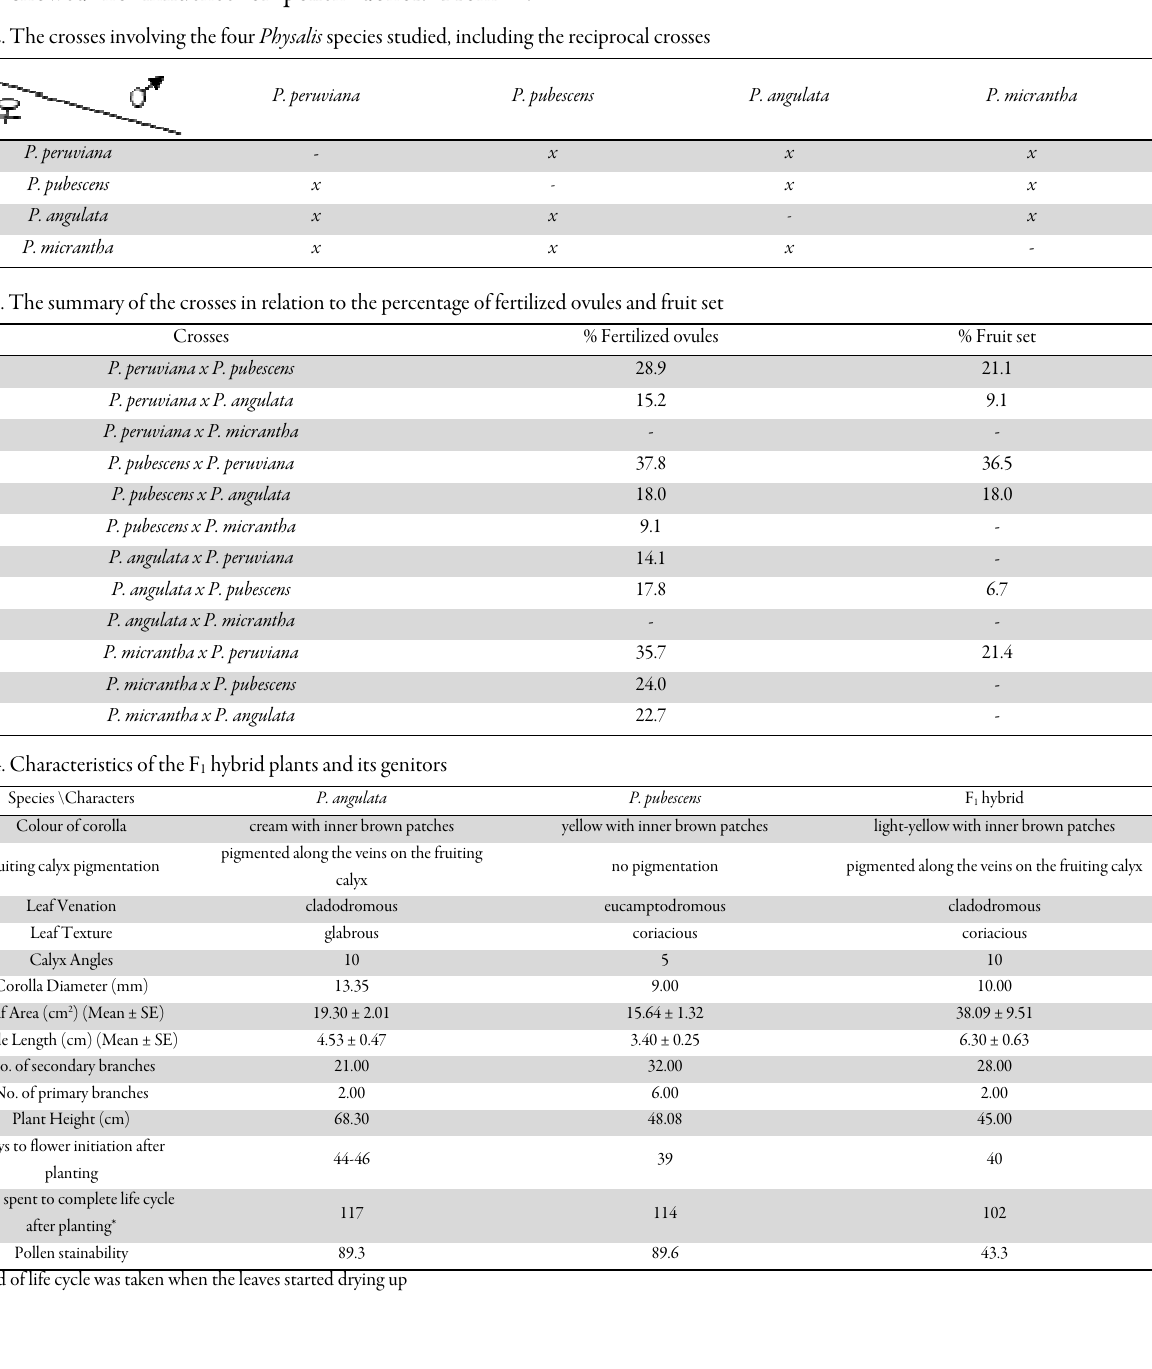
Table 2. The crosses involving the four Physalis species studied, including the reciprocal crosses